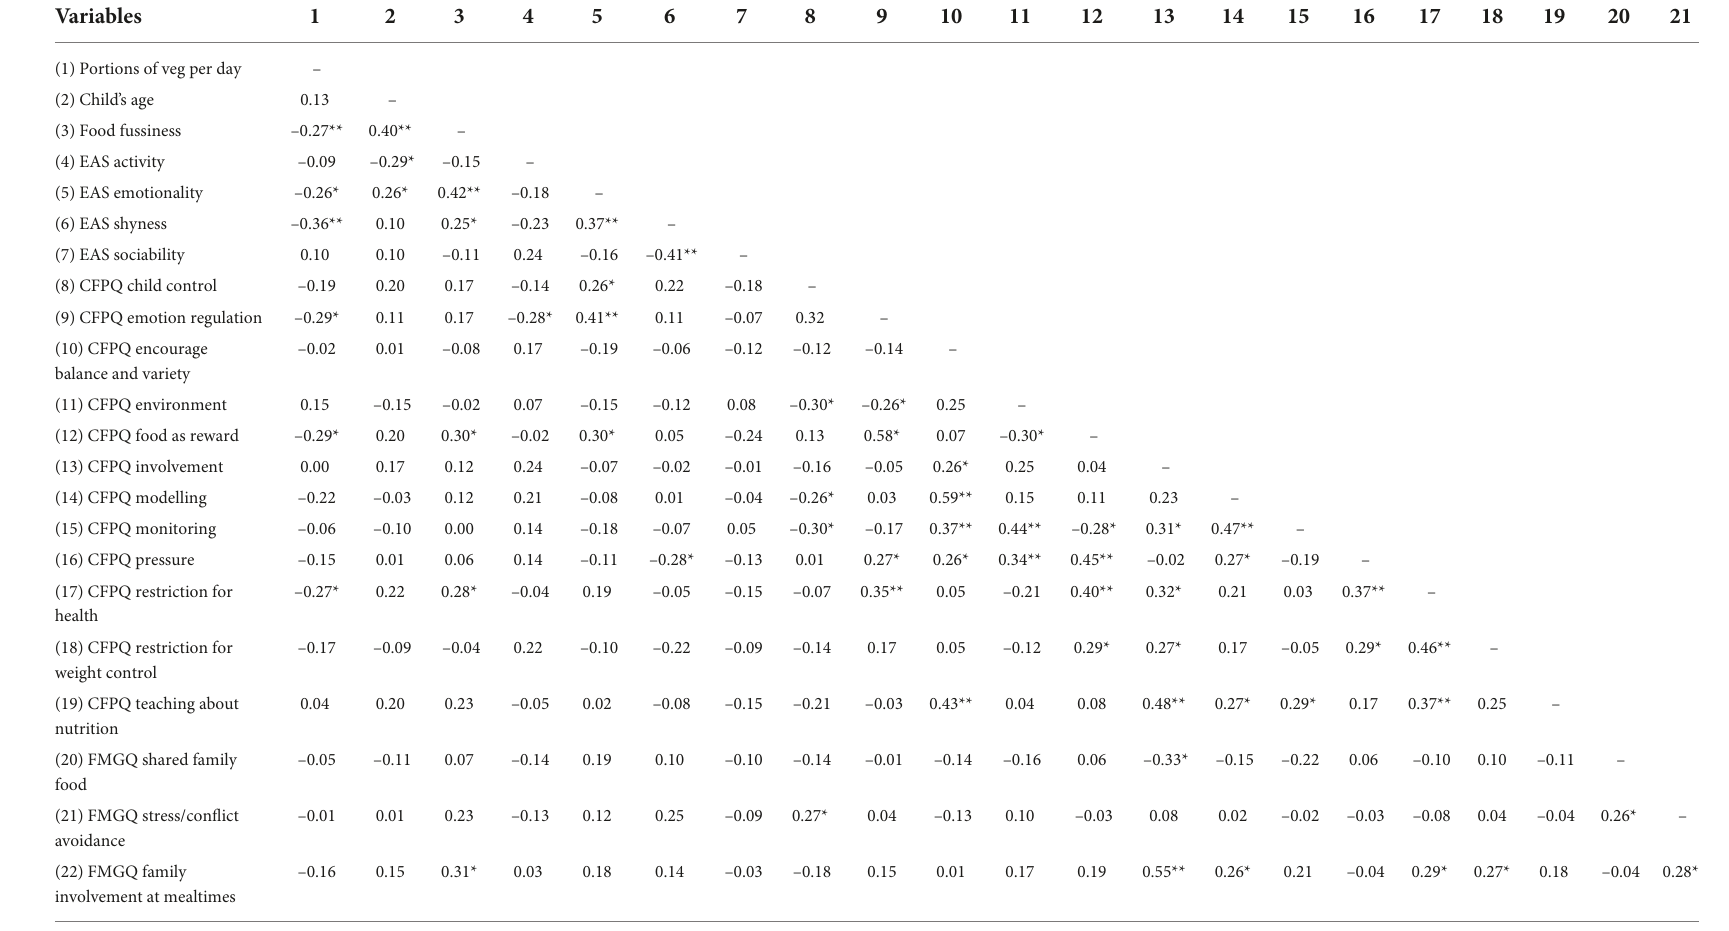
TABLE 7 Correlations between vegetable consumption and parent and child measures, Italian sample ( N = 61).